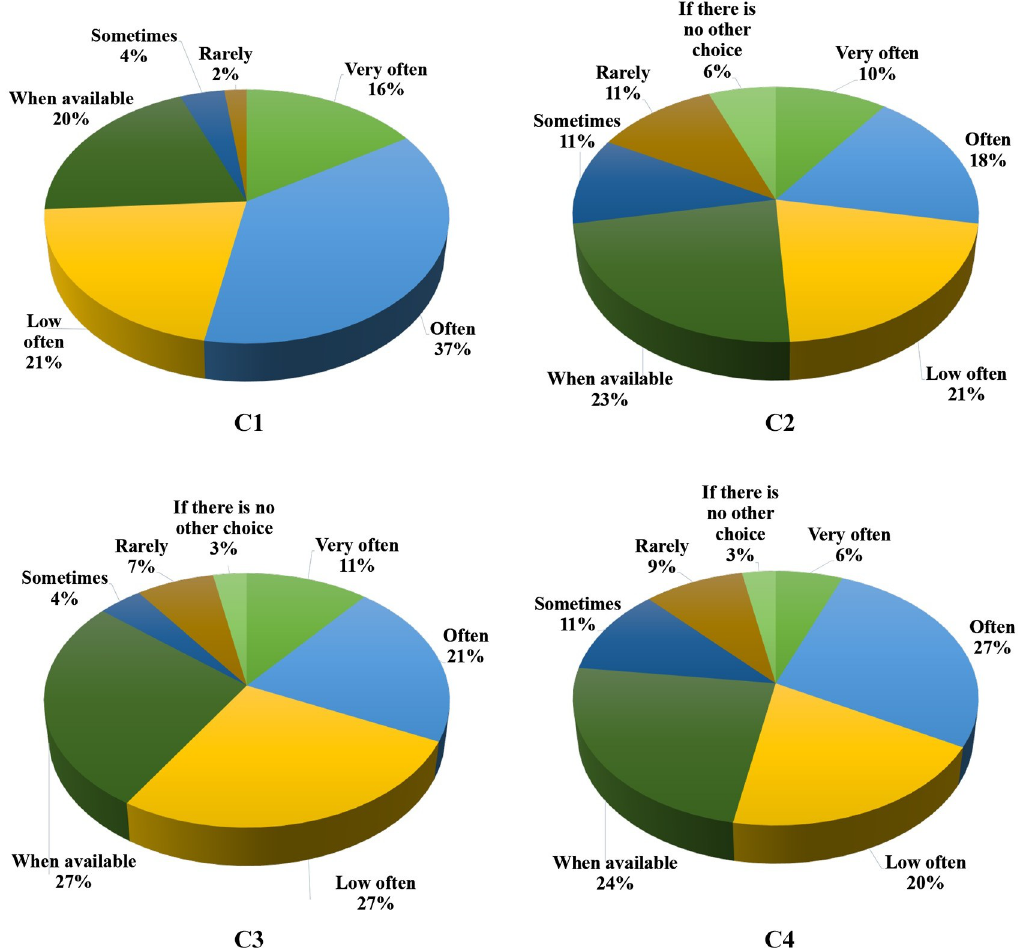
Fig 6. Intention of consumption frequency of the cookies. C1—wheat flour cookies (control1), C2–50% xiquexique flour (100 mesh) cookies, C3—whole wheat flour cookies (control2) and C4–50% whole xiquexique flour (28 mesh) cookies.